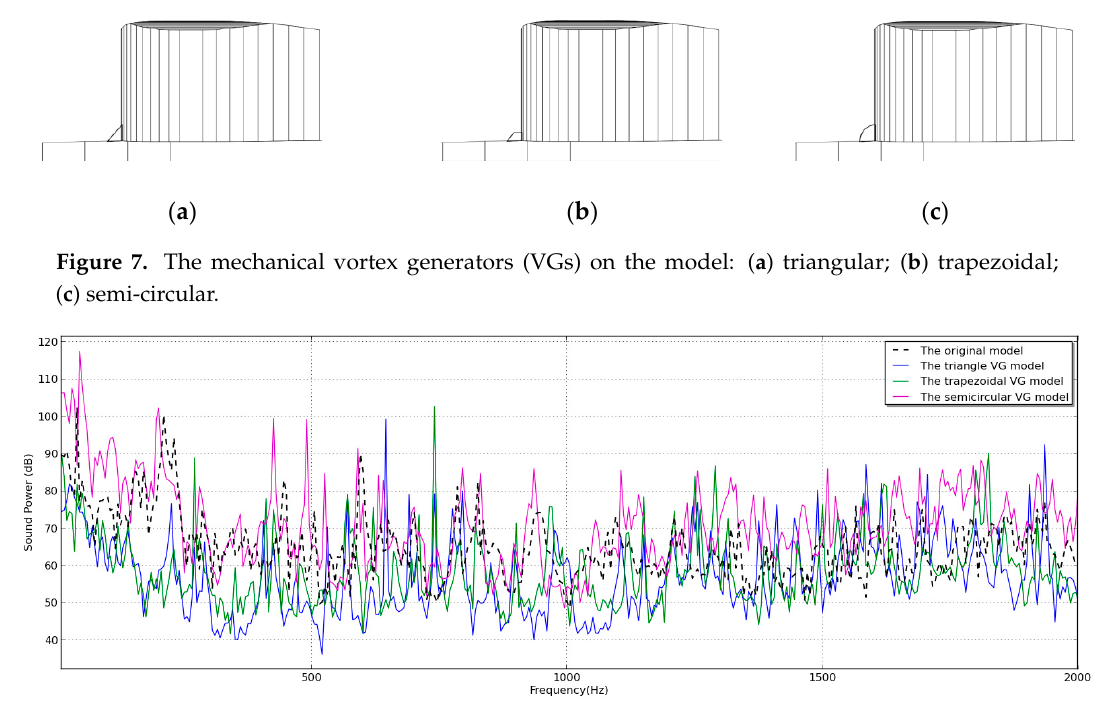
Figure 8. The radiated sound power from the original model and the models with three shapes of mechanical VGs.